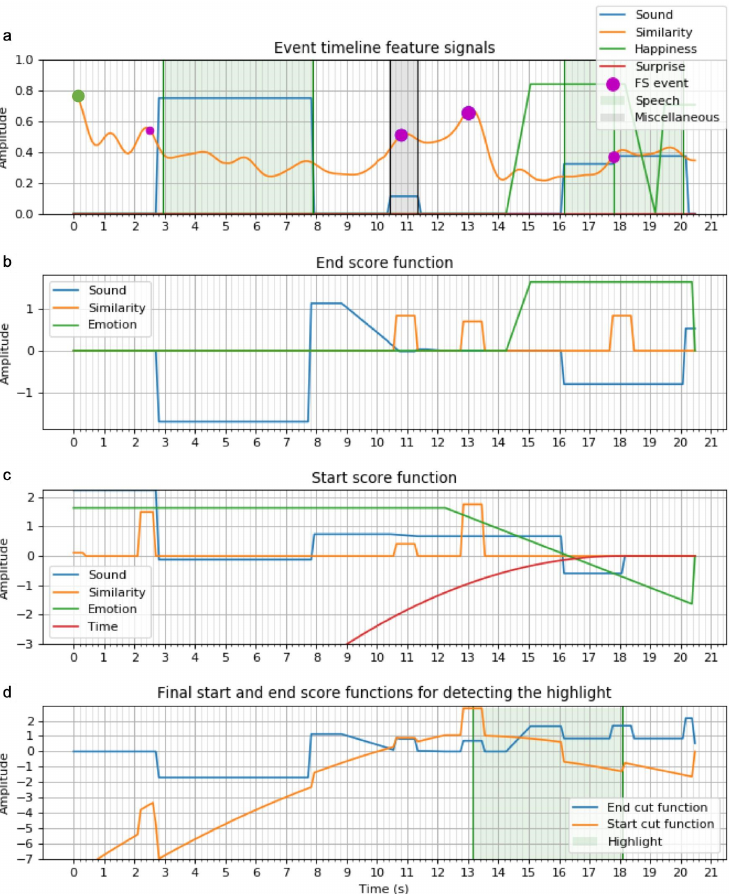
Figure 13. Score functions computation processes to derive both start and end highlight cuts: ( a ) events timeline signals, ( b ) sub-functions to compute end cut score function, ( c ) sub-functions to compute start cut score function, ( d ) resulting start and end score functions for highlight classification The function pattern associated with an emotional event is represented in Figure